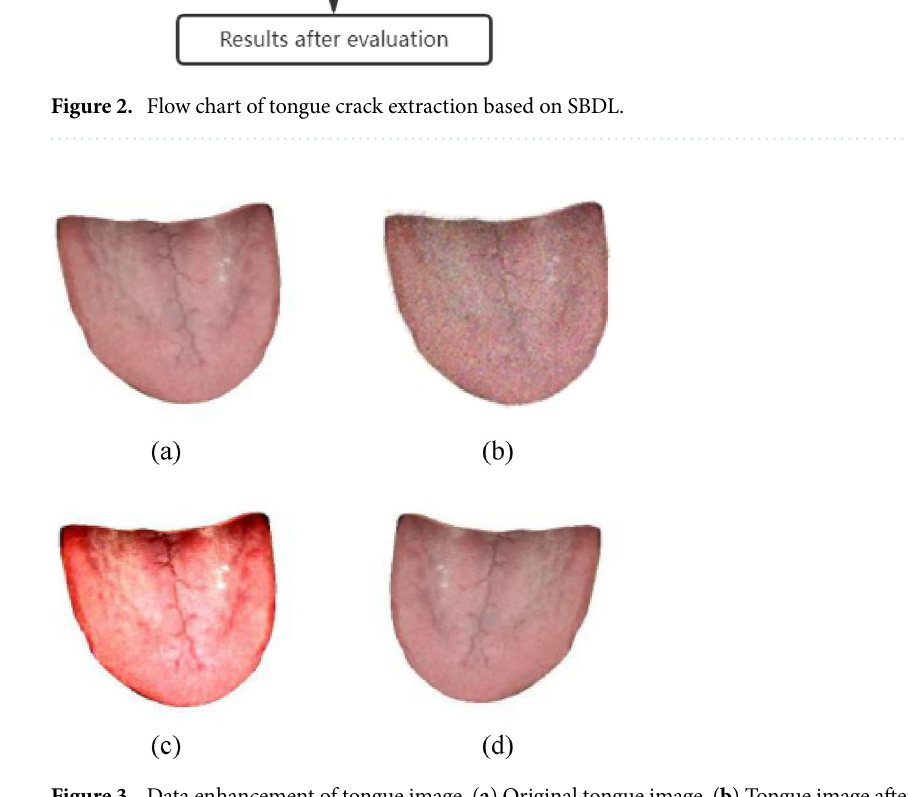
Figure 3. Data enhancement of tongue image. ( a ) Original tongue image. ( b ) Tongue image after adding salt and pepper noise. ( c ) Tongue image after changing contrast. ( d )Tongue image after horizontally